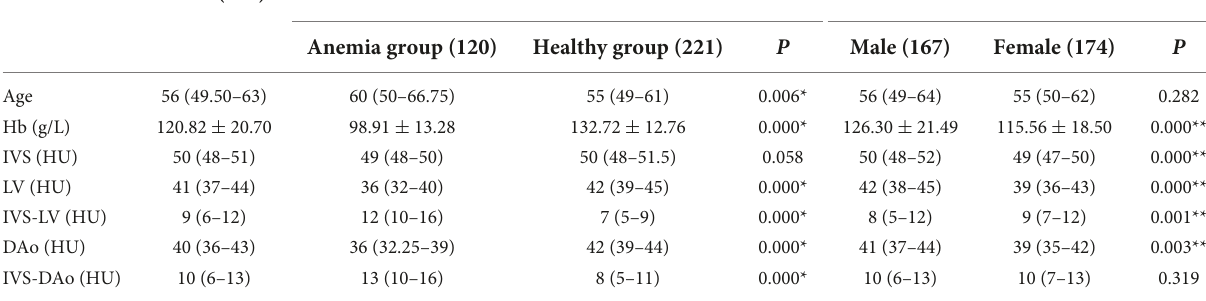
TABLE 3 Descriptive analysis of baseline characteristics in CDCT group.